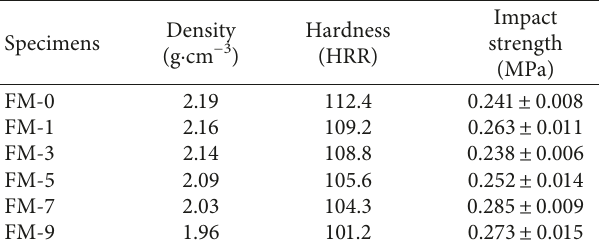
Figure 6: Morphologies of (a) the untreated corn stalk fibre and (b) the corn stalk fibre treated with NaOH solution. Table 2: Physical and mechanical properties of the friction